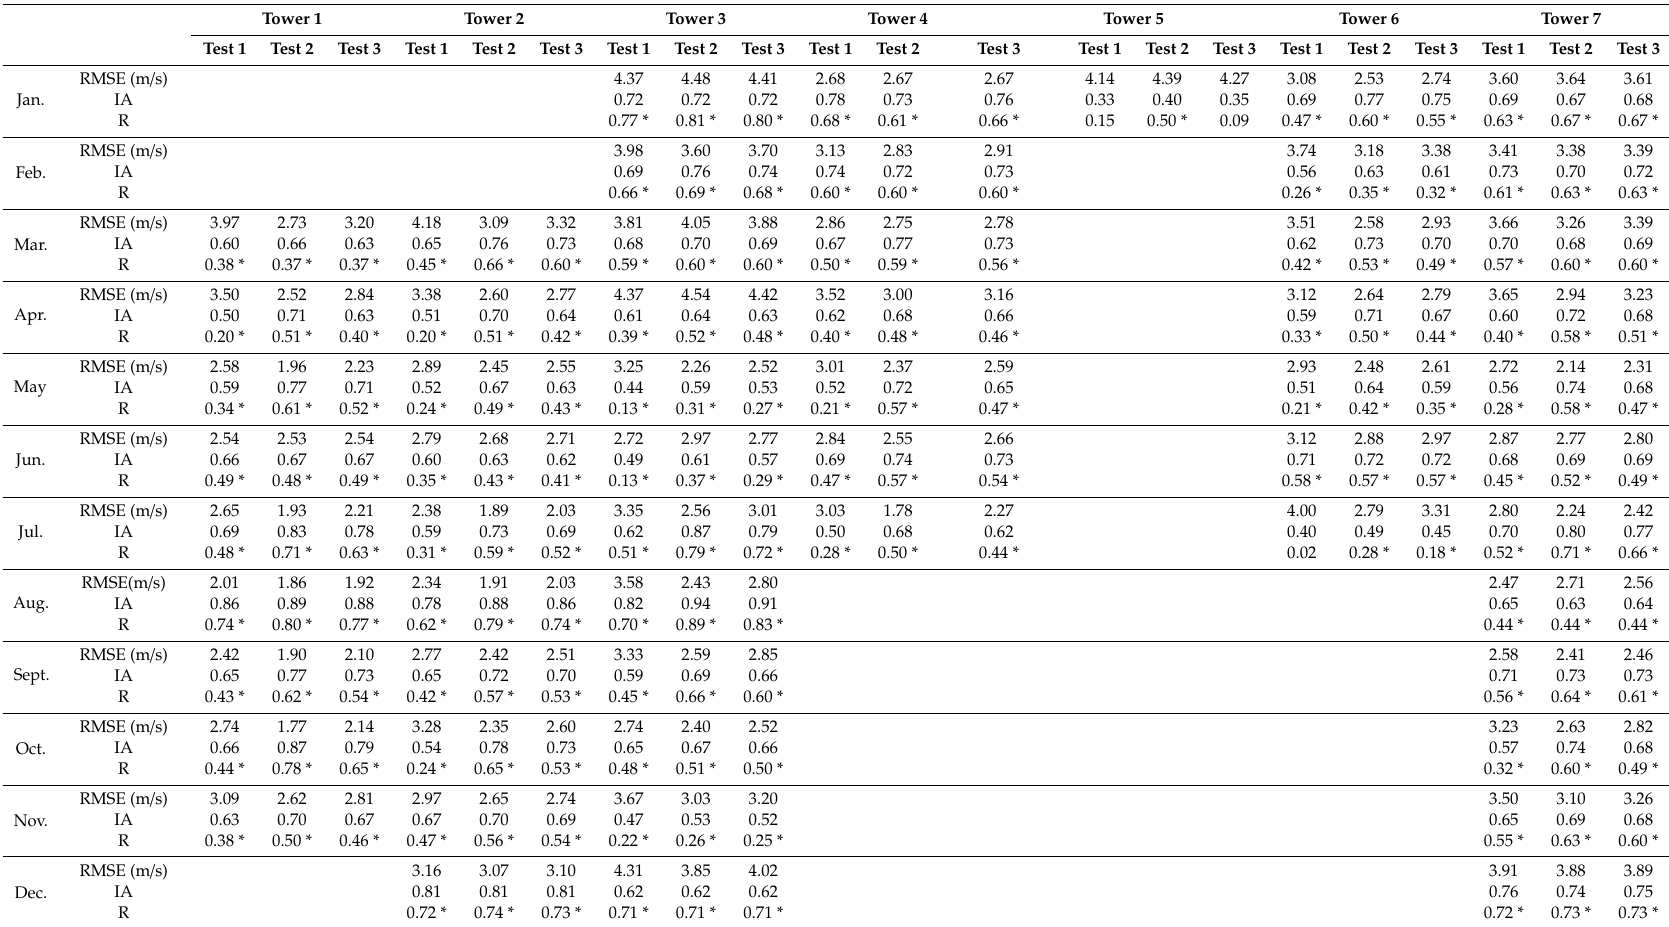
Table A2. Statistical results of Test 1, Test 2, and Test 3, at 50 m height. Tower 1 Tower 2 Tower 3 Tower 4 Tower